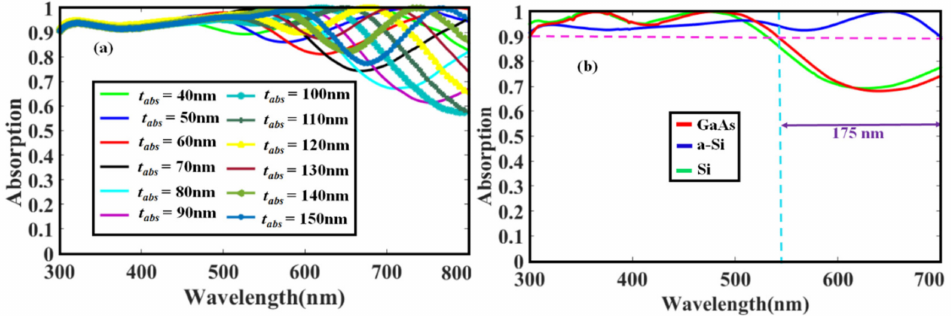
Figure 5. Influence of ( a ) thickness of the absorbing layer and ( b ) di ff erent materials on absorption e ffi